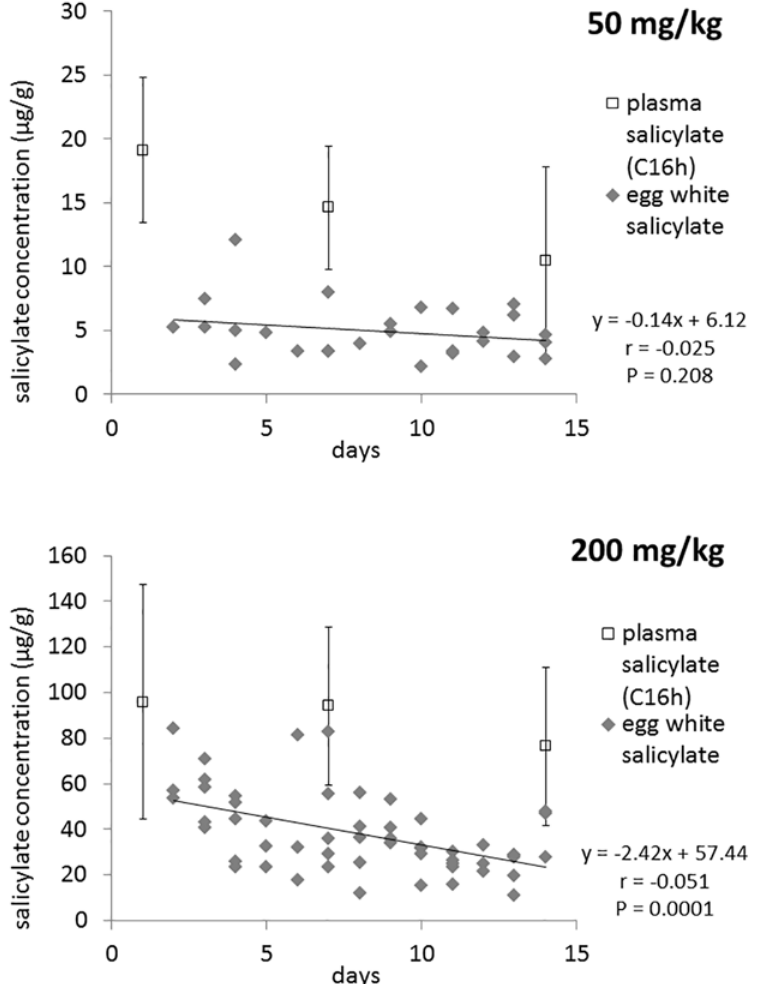
Fig 2. Salicylate (SA) concentrations in egg white of eggs collected from day 2 to 14. To show the relation with blood SA levels, plasma drug concentration at 16 h post administration (C 16h ) is included. Linear regression analysis was performed to investigate the statistical significance of the time-dependent changes in egg white